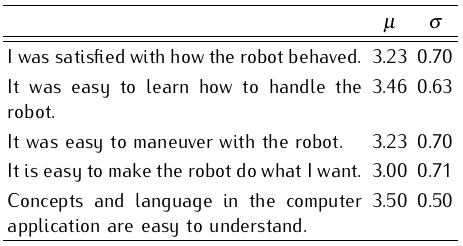
Table 9. A summary of the response regarding the perceived ease of use of the system. 0 = I do not agree at all, 4 = I fully agree I was satisfied with how the robot behaved. 3.23 0.70 It was easy to learn how to handle the robot.